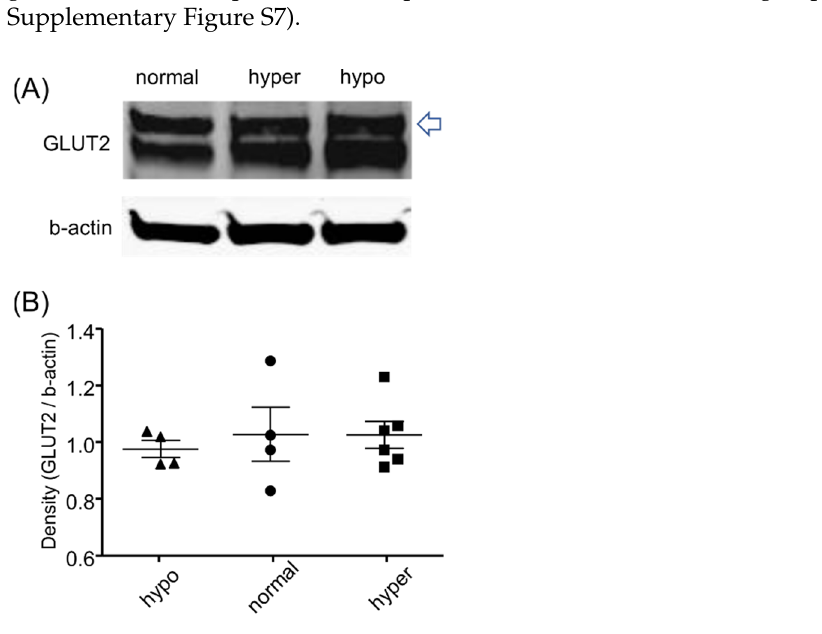
Figure 5. Effects of blood glucose level on 2-NBDG (2 or 6 mg/kg) transport from cytosol to inter- stitium in early segments of proximal tubules. P1/2/T1/2 was compared between groups. Hypo: hy- poglycemia, normal: normoglycemia, hyper: hyperglycemia. Each dot represents an average value from five proximal tubule cells in each mouse ( n = 3–8 for the 2 mg/kg group and n = 3–5 for the 6 mg/kg group).